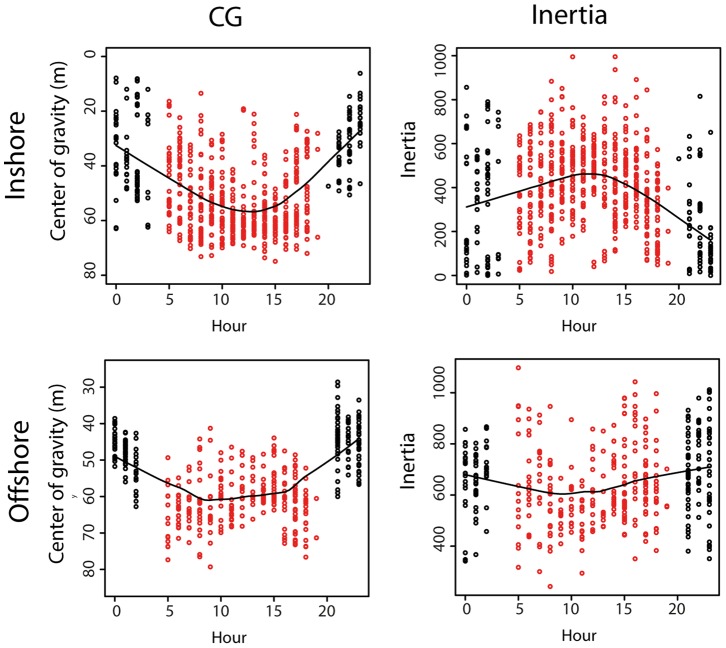
Day-night distributions of macrozooplankton.The centre of gravity (CG) of and the related inertia are analyzed according to the inshore and offshore regions. Day distributions are represented in red and night distributions in black. The black solid lines shows the smoothed distribution of the scattered data.